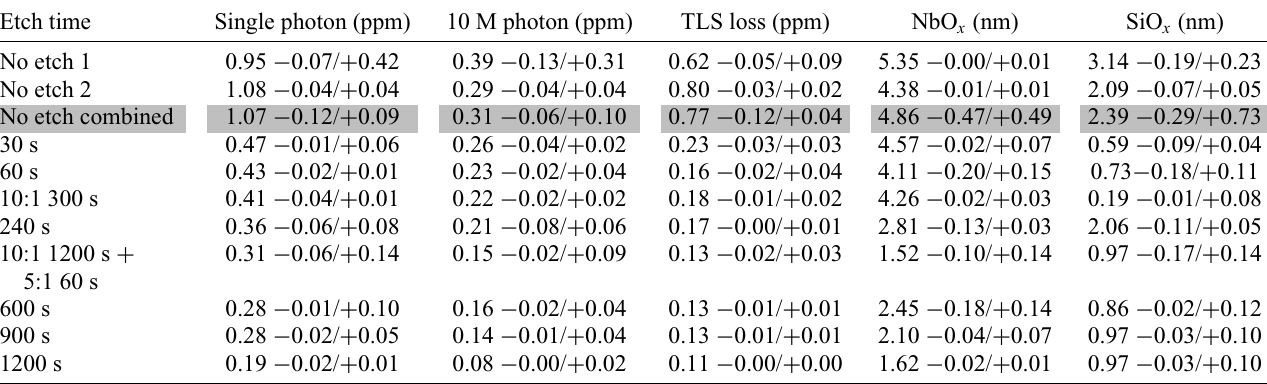
TABLE I. Tabulated median values of etched chips as a function of the etching conditions. The columns are the single-photon, 10 7 photon, and TLS losses, followed by the niobium and silicon oxide thicknesses determined by XPS. The shaded horizontal row has the combined median properties of the tested standard resonators. The ± ranges are first and third quartiles. Medians and quartiles are used instead of mean and standard deviations since some chips have outliers, individual resonators with values far from the median that skew the mean and standard deviation values. Medians and quartiles are less sensitive outlier effects in small